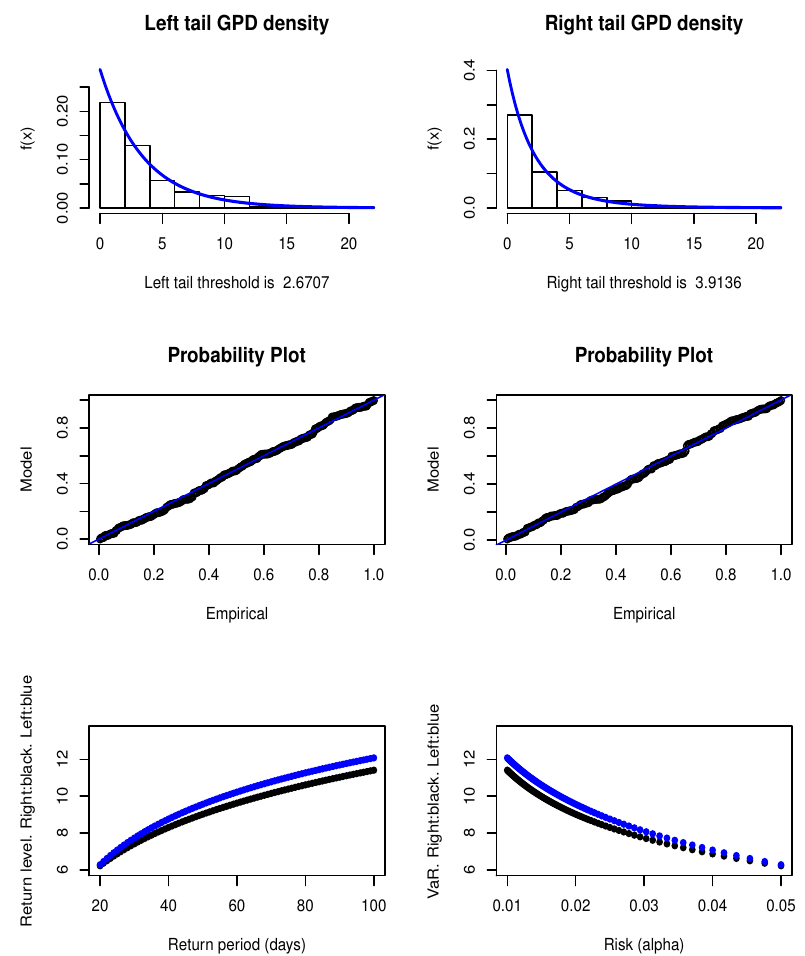
Figure 3. The first and second rows show the Bitcoin GPD’s graphical diagnosis for the left and right tails. In the third row the return level is shown in days with the corresponding α -VaR, for the left tail (blue) and right tail (black) of